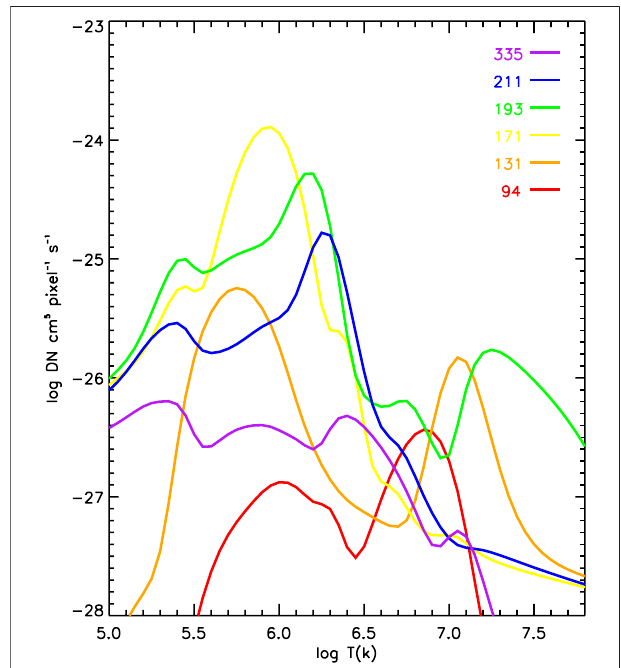
FIGURE 1 | AIA temperature response curves from SSW routine (aia_get_response.pro) showing the temperature sensitivity of the different fi lters with 94 Å (red), 131 Å (orange), 171 Å (yellow), 193 Å (green), 211 Å (blue), 335 Å